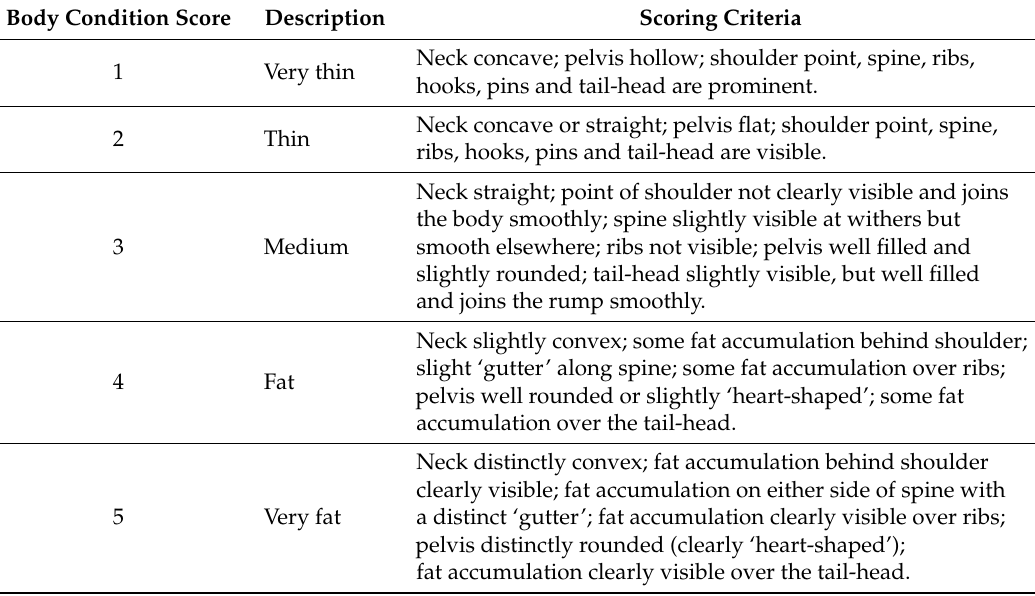
Table 1. Scoring criteria for body condition. If all criteria for a full score were not attained, a half score was awarded [19].